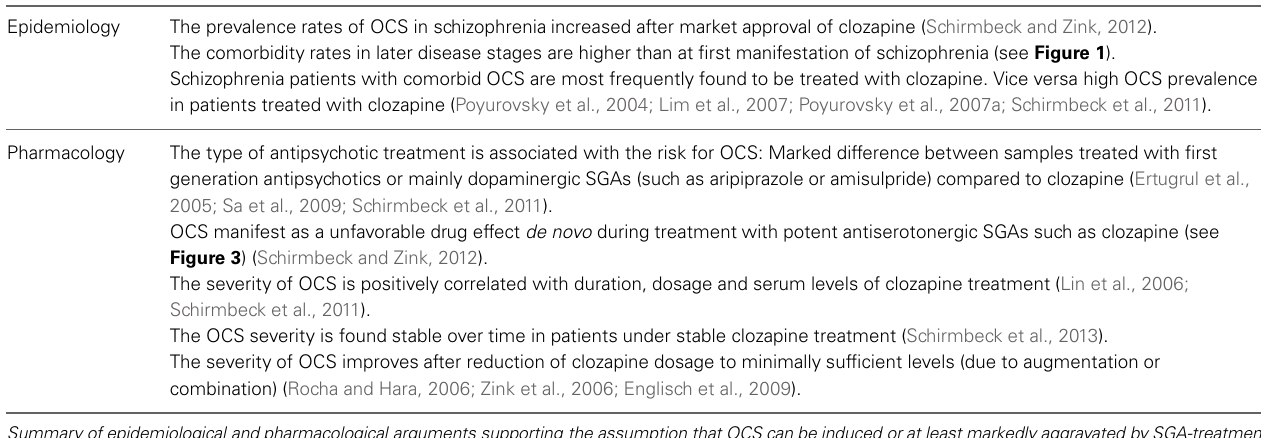
Table 2 | Arguments supporting SGA-induction of